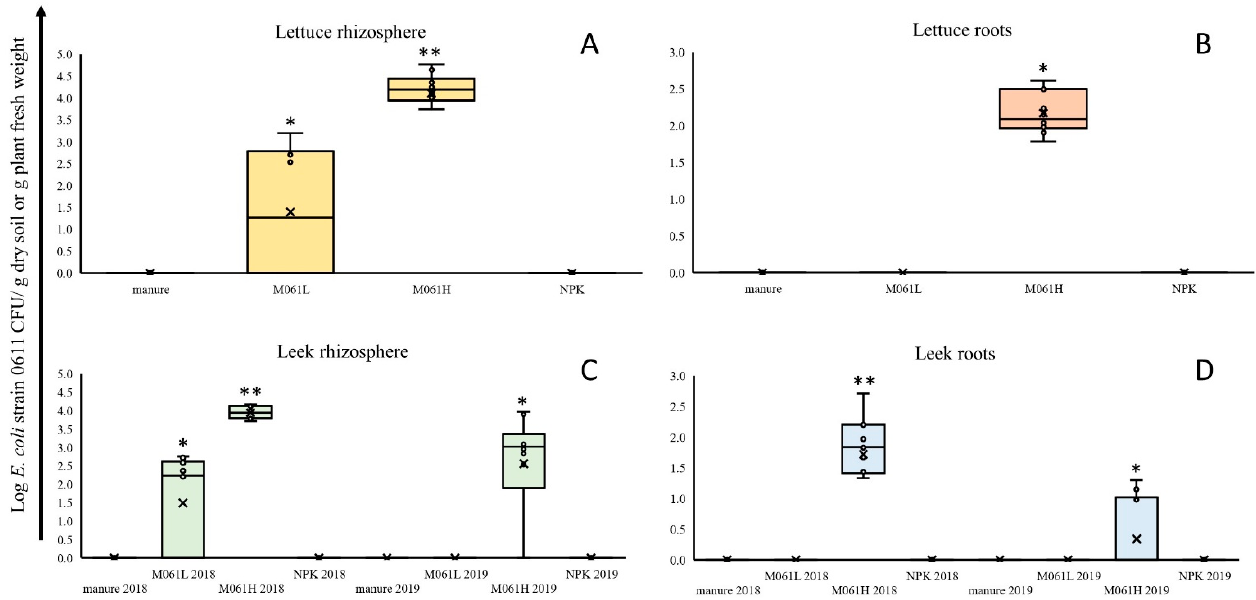
Figure 1. Colonization, as determined by E. coli strain 0611-specific colony formation, of rhizosphere soils ( A , C ) and roots ( B , D ) of lettuce plants sampled at 39 DAP ( A , B ) and of leek plants sampled at 90 (2018) and 272 DAP (2019) ( C , D ), grown in soils under four different treatment regimens (manure, M0611H, M0611L, NPK). Bars marked with * and ** indicate significant difference ( p ≤ 0.05) in average Log CFU values between soil treatments, whereby ** > *.